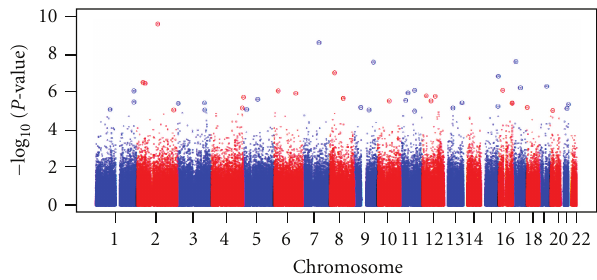
Figure 4: Overview of genome-wide association study of cockroach sensitization in the African American population. Manhattan plot showing the association of 644,709 SNPs by chromosome for P value. The x -axis represents cockroach allergy versus − log 10 ( P genomic position, and the y -axis shows − log 10